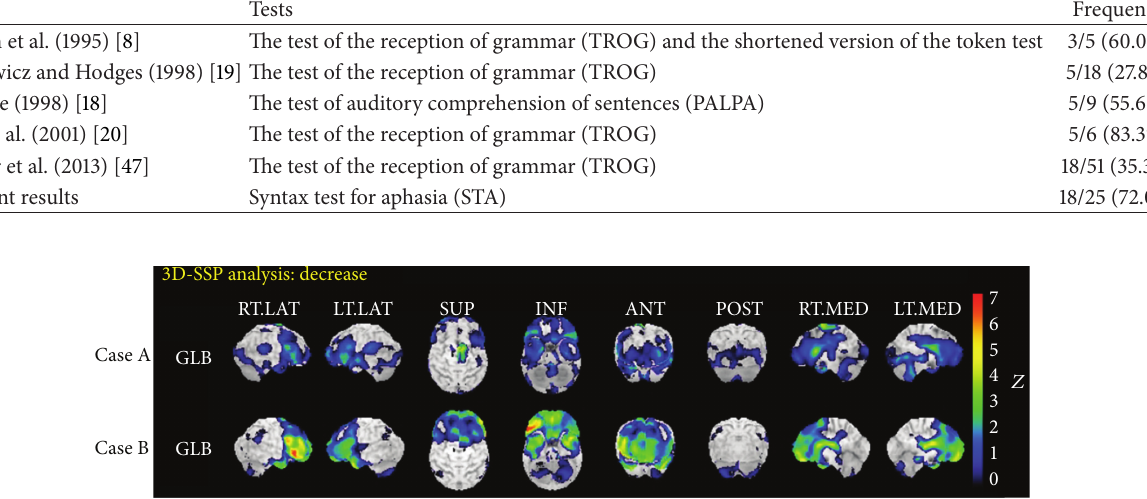
Table 6: Previous reports of the frequency of syntactic comprehension disorders in amyotrophic lateral sclerosis and motor neuron disease.